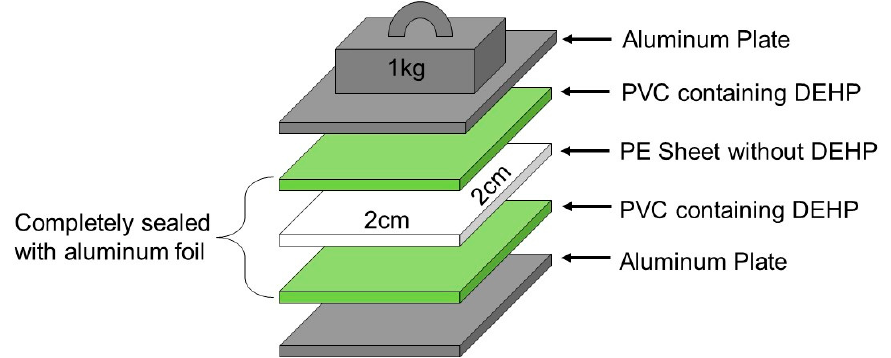
Figure 1. Sandwich system for the phthalate migration test. Legend: polyvinyl chloride (PVC), polyethylene (PE).